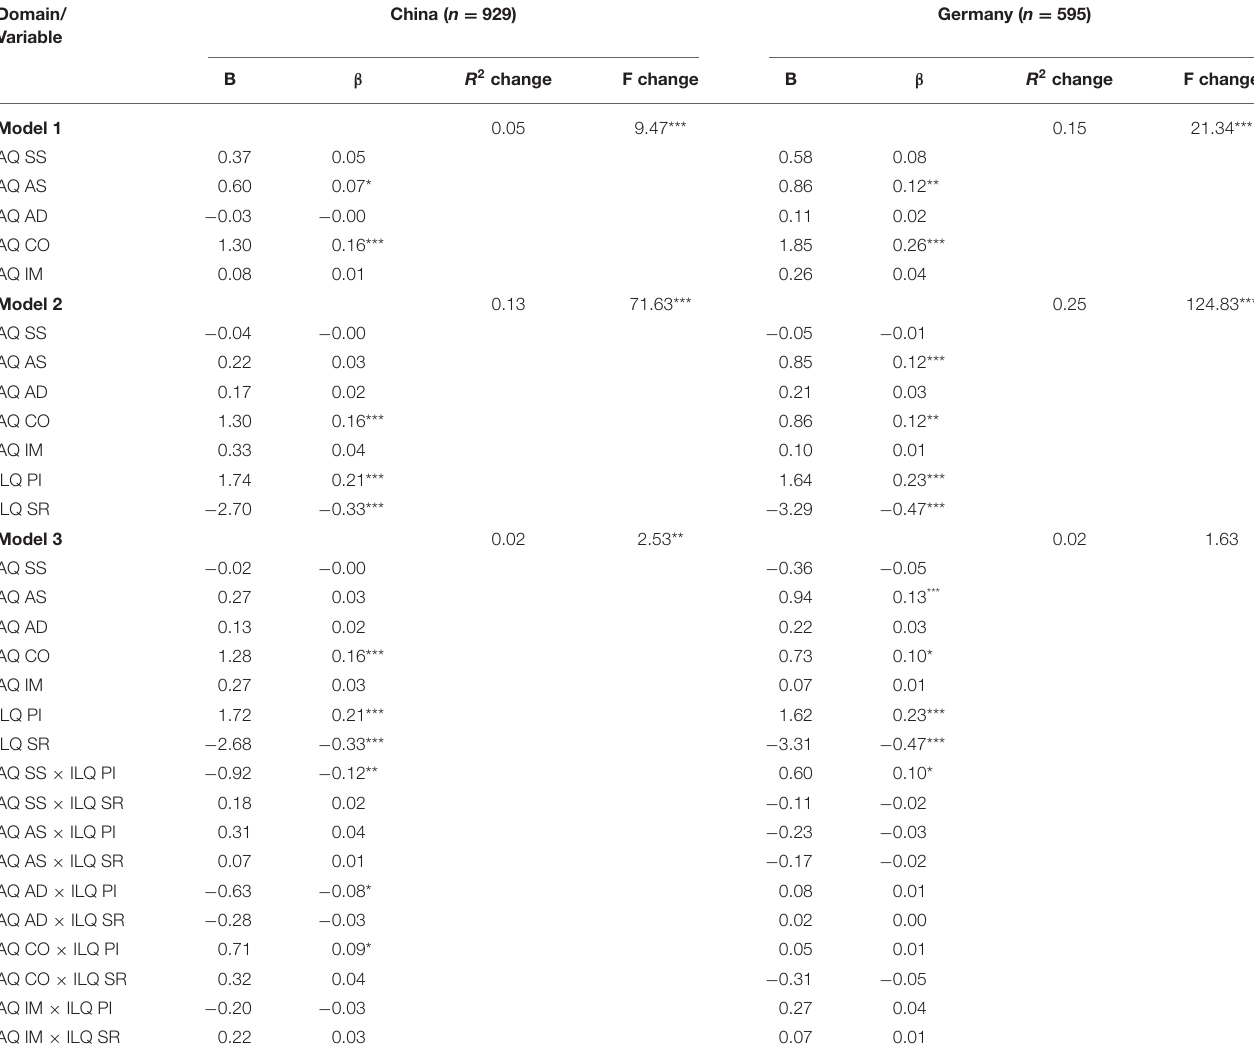
TABLE 8 | Regression coefficients of the moderated regression analyses with s-IAT total scores as dependent variable, AQ subscales’ scores and ILQ dimensions as independent variables. Domain/